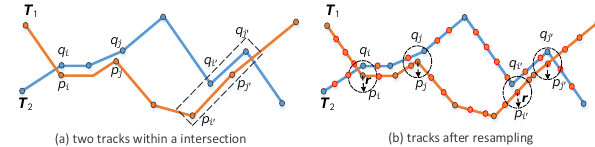
correspondence between GPS points of T 1 and T 2 (the black box of Figure 2-a). Trajectory points are resampled between the adjacent points with a step of min_Len as shown in Figure 2-b.